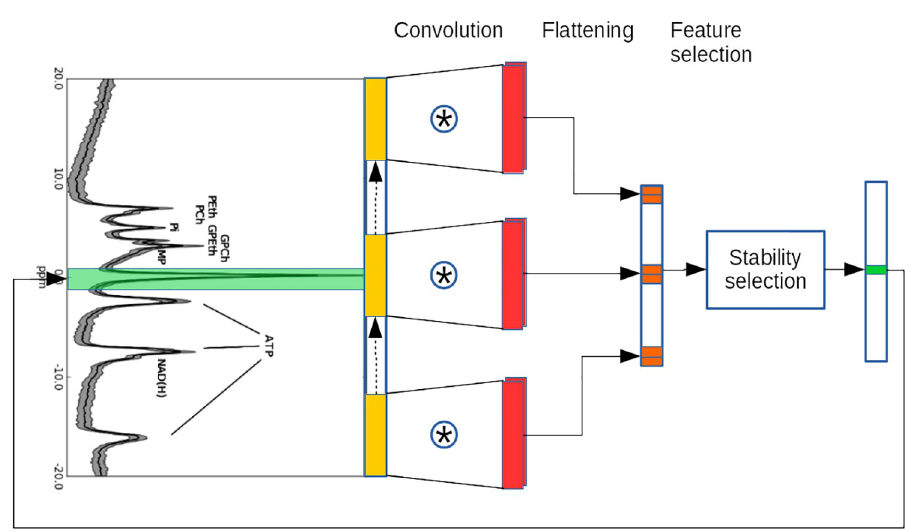
Fig 4. Example of identification of important spectral regions using stability selection on the output of SL-CNN. Stability selection is applied to the output of the convolutional layer after the neural network has been trained. Based on the convolutional layer parameters (i.e. number and size of the kernels and stride of the convolution), it is possible to map them to a specific region of the input spectrum.